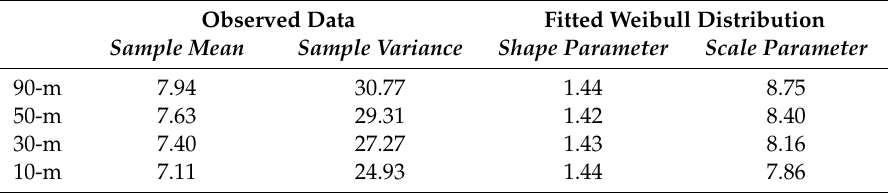
Table 1. Statistical properties of the wind speed data and the fitted Weibull distributions.